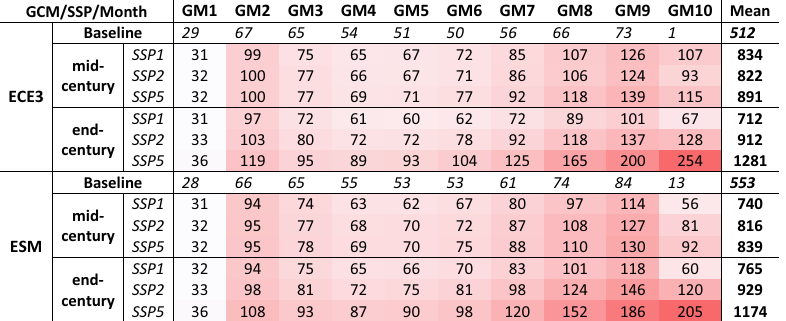
Table 2. Elevation-distributed mean annual glacier melt (GM) in mm in the Hunza basin for baseline and future periods under all scenarios.